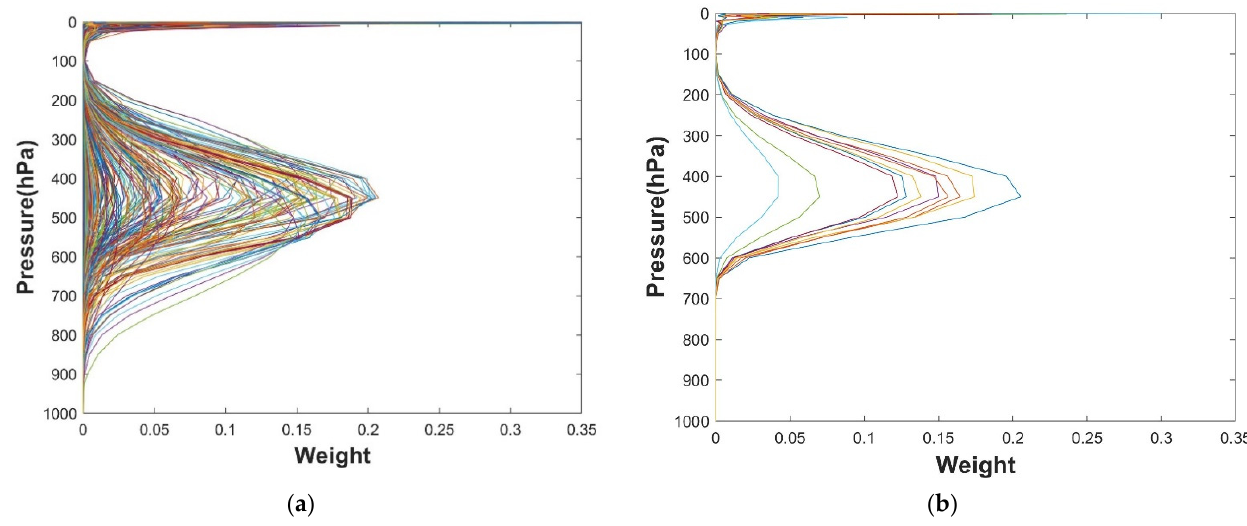
Figure 8. Weight function curve. ( a ) The channels with wavenumbers from 1700 cm − 1 to 1920 cm − 1 . ( b ) The 10 channels we selected.